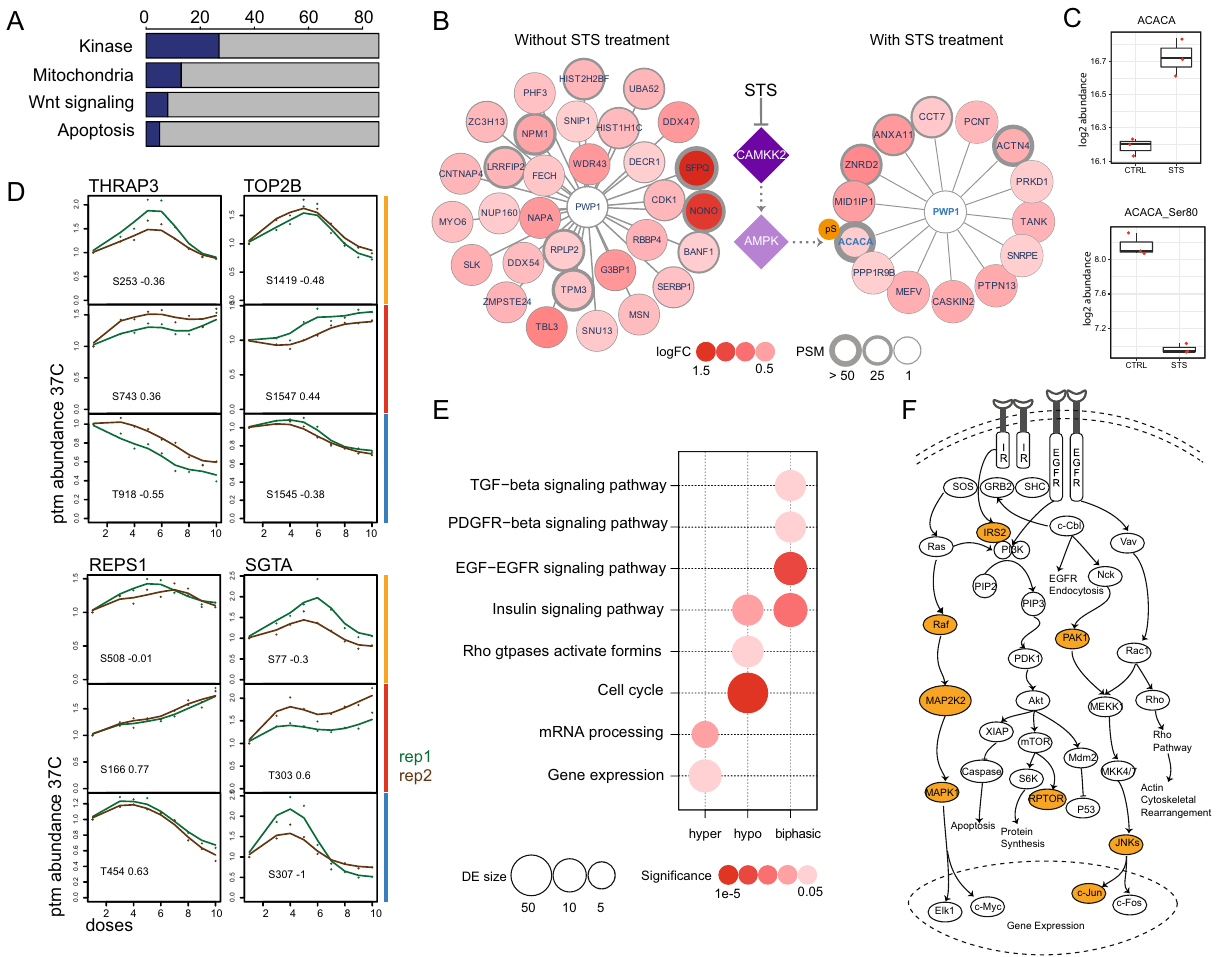
Figure 2. Impact of STS on the non-kinome and phosphoproteome. ( A ) The number of hits identified as kinases, and/or localized to the mitochondria, related to Wnt signaling and/or apoptosis. ( B ) Changes in PWP1 protein complex upon STS treatment as analysed by MS-immunoprecipitation. Hit proteins are defined by average log2 fold change (logFC) < − 0.5 or > 0.5, adjusted p-value < 0.05, from three replicates. PSM (number of peptide-spectra match per protein). CAMKK2 and AMPK were identified in the ProteomeImpact experiment (Fig. 1F), with CAMKK2 identified as a direct interactor of STS (solid purple fill). Known regulation of AMPK by CAMKK2 27–30 (as indicated by the faint purple fill and dotted lines). ( C ) Log 2 abundance intensity of the total protein (ACACA) and its phosphosite ACACA-Ser80 with (STS) and without (CTRL) treatment. ( D ) Phosphopeptide response curves for four proteins with all three response patterns: thyroid hormone receptor- associated protein 3 (THRAP3), DNA topoisomerase 2-beta (TOP2B), RalBP1-associated Eps domain- containing protein 1 (REPS1), small glutamine-rich tetratricopeptide repeat-containing protein alpha (SGTA). The doses were represented as ordinal numbers, with the highest dose 10.0 µM at position number 10 (x-axis). The ptm (post-translation modification) abundance 37C (y-axis) represents the abundance fold change relative to the untreated condition. Coloured bars indicate biphasic (yellow), hyper-phosphorylation (red) and hypo- phosphorylation (blue), green and brown lines represent two biological replicates. ( E ) Differential phosphosites are clustered by biological processes involved. DE size (differential expression size), significance (enrichment significance). ( F ) Signaling network of epidermal growth factor receptor (EGFR) and insulin receptor (IR). Proteins with biphasic phosphorylation response in this pathway (shaded